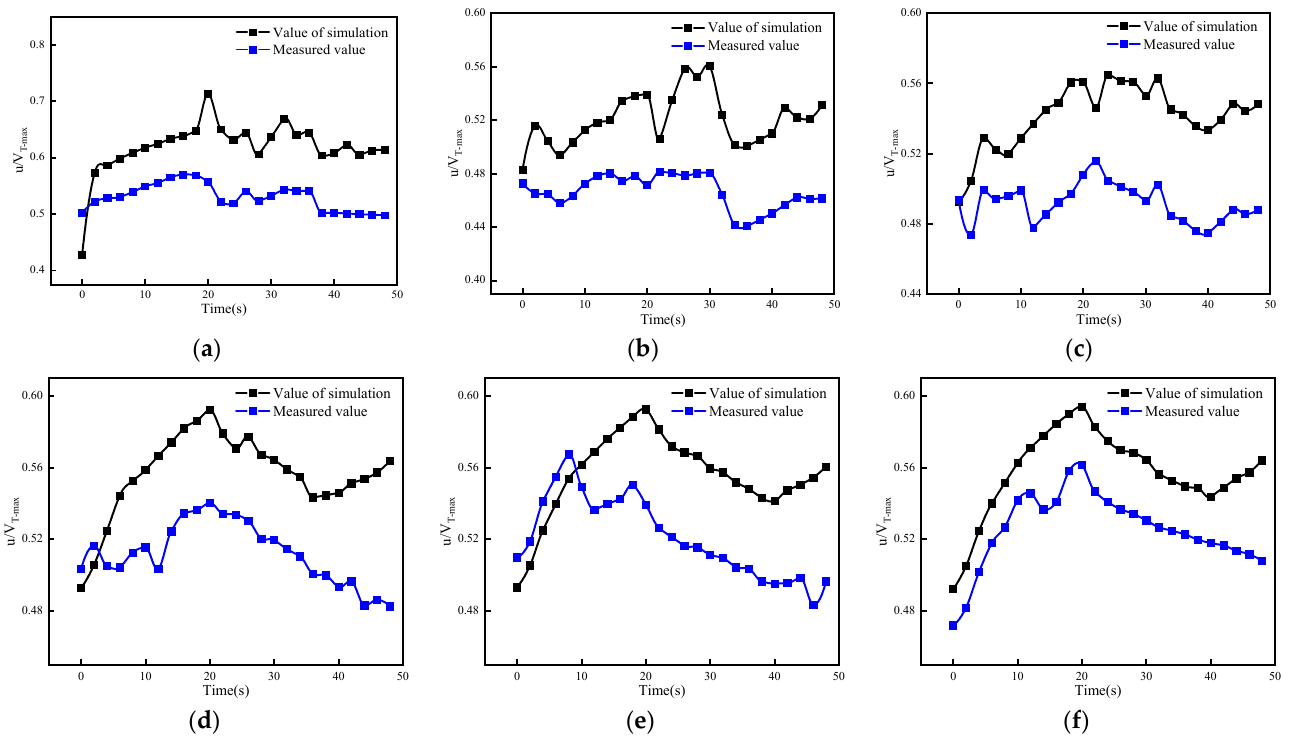
Figure 5. Comparison of simulated and measured piston wind speed: ( a ) Verify the value point a, ( b ) Verify the value point b, ( c ) Verify the value point c, ( d ) Verify the value point d, ( e ) Verify the value point e, ( f ) Verify the value point f.